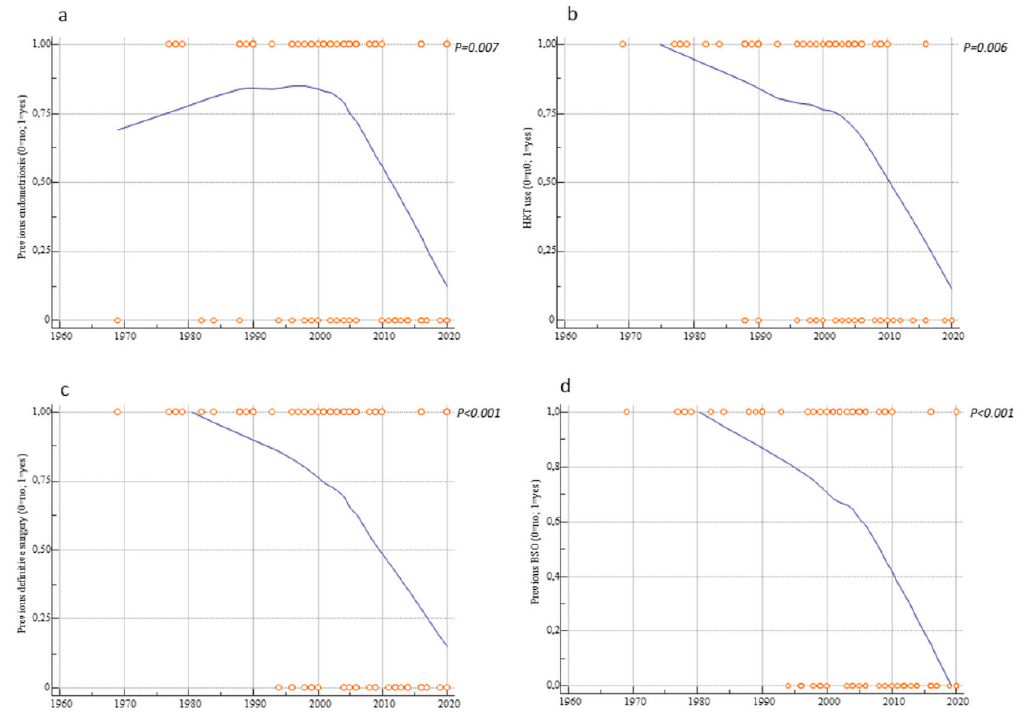
Figure 2. Scatter diagrams showing the trend over time of ( a ) previous endometriosis; ( b ) hormonal replacement therapy